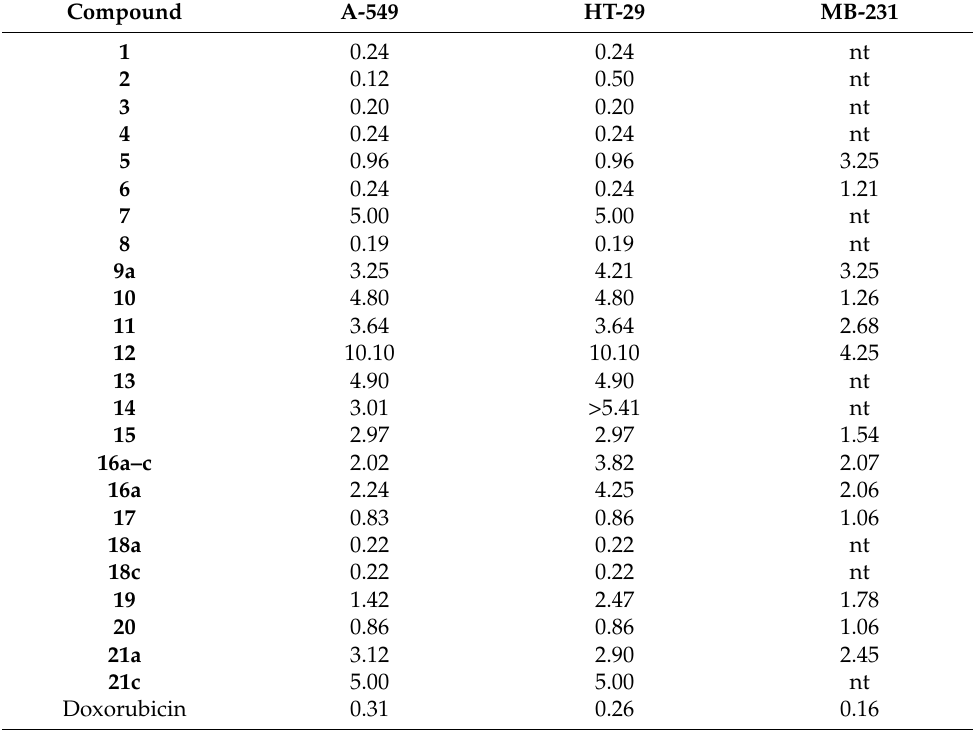
Table 1. Antineoplastic cytotoxicity (GI 50 values in µ M) of DTHQs 1 – 21 against A-549 (lung), HT-29 (colorectal) and MB-231 (breast) tumor cell lines (nt: not